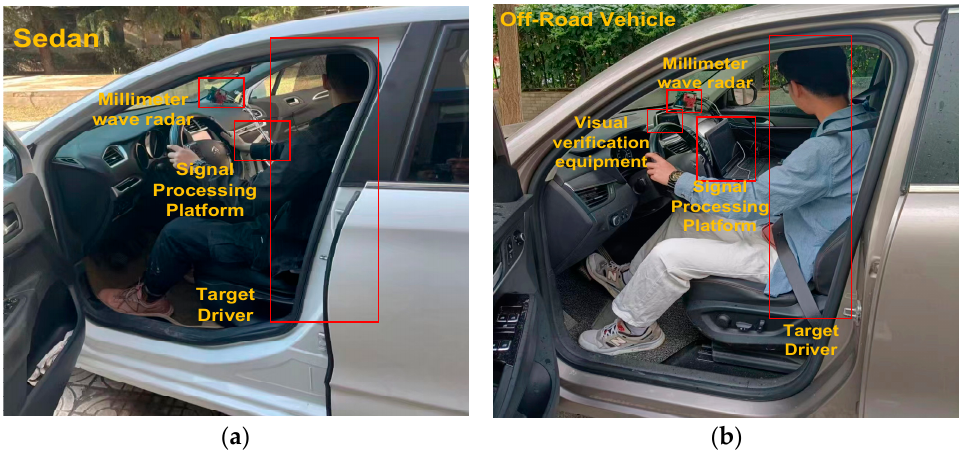
Figure 8. ( a ) Sedan experiment; ( b ) off-road vehicle experiment.